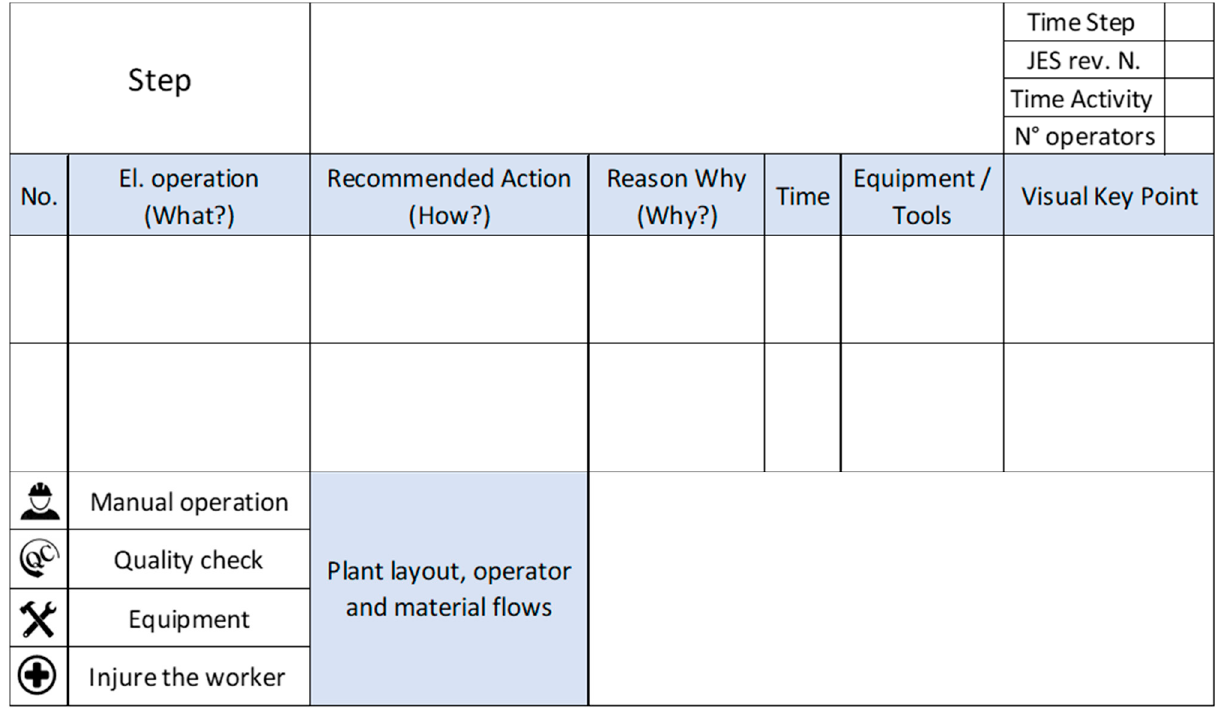
Figure 2. Design-job element sheet (D-JES).